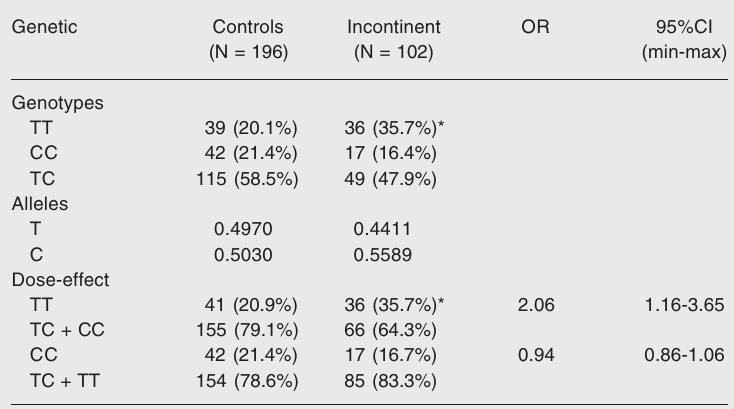
Table 2. Comparison of 5-HT2A allelic, genotype and dose-effect genotype frequency between urinary incontinent and control